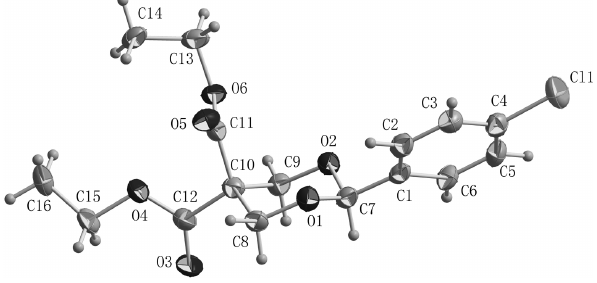
Table 1: Data collection and handling.